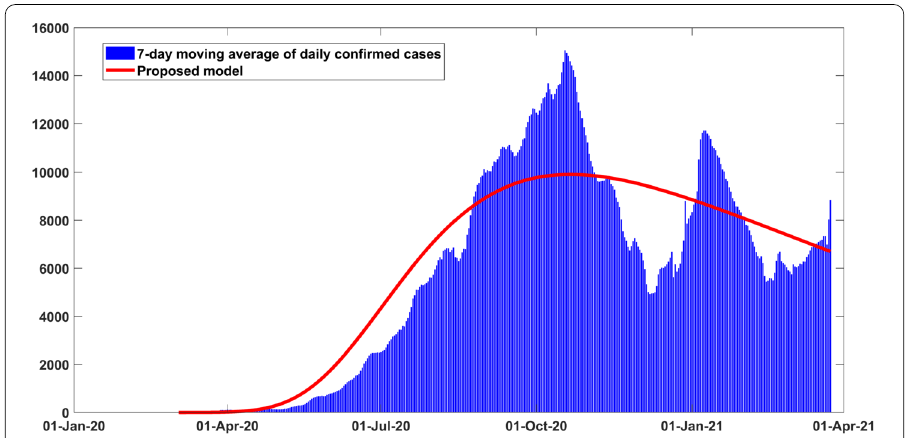
Figure 2 Output of the model performance fitting for daily cases of infection in Argentina from March 03, 2020 to March 29,